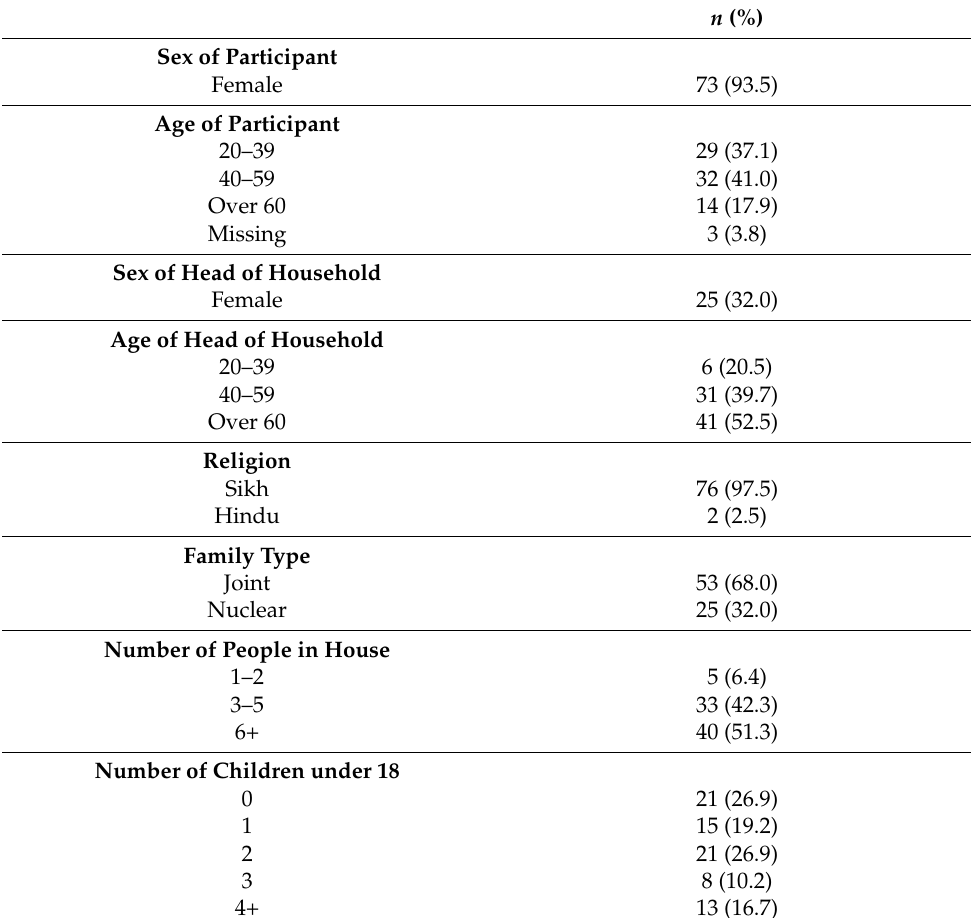
Table 1. Demographic characteristics, n =